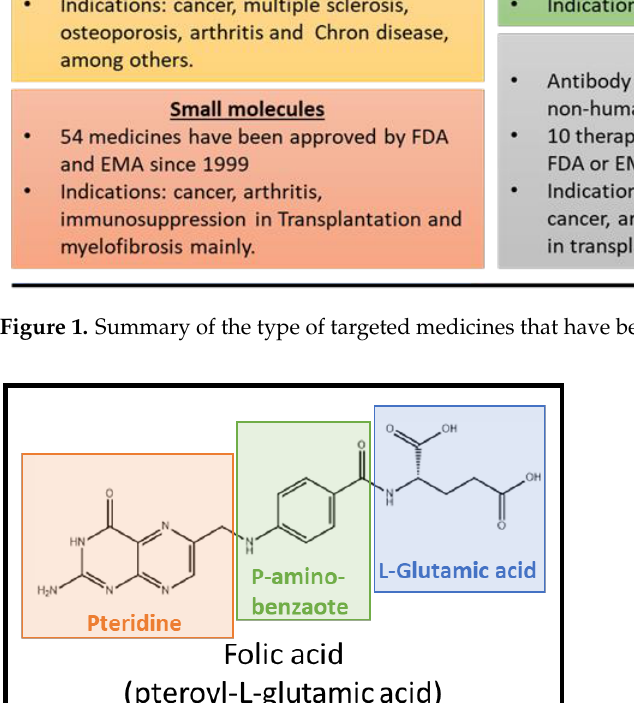
Figure 2. Structure of folic acid.